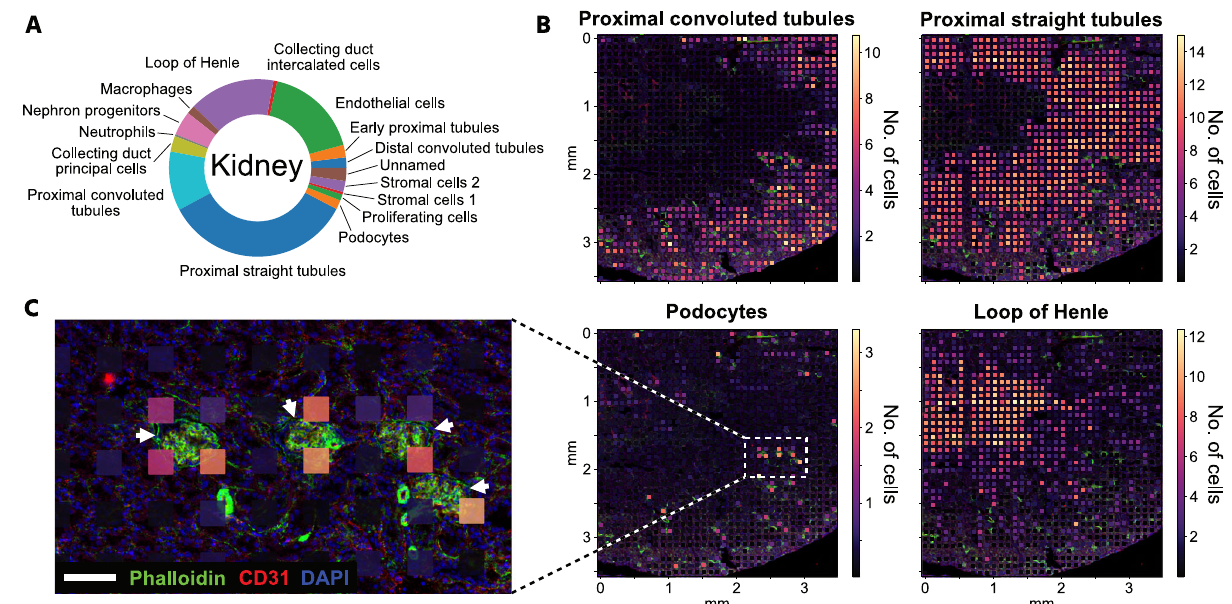
Fig. 5 | Deconvolution of xDBiT kidney dataset to spatially resolve cell types. A Data of one representative kidney section was deconvolved using cell2location 13 and a single-cell RNA-seq dataset of the murine kidney 41 . Pie chart shows the cell type composition of the deconvolved kidney section. B High-resolution fl uores- cence images overlaid with xDBiT spots colored for the deconvolution results of